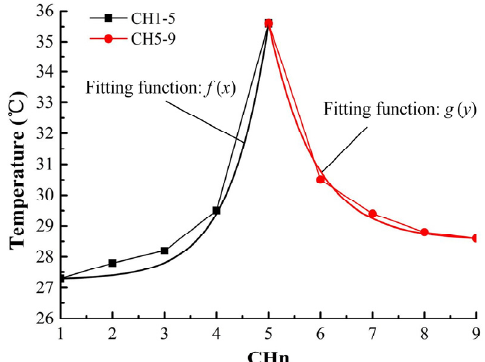
Figure 9. Thermal deformation calculation principle of valve orifice in the optimization algorithm based on measurement data (M-OA) method.